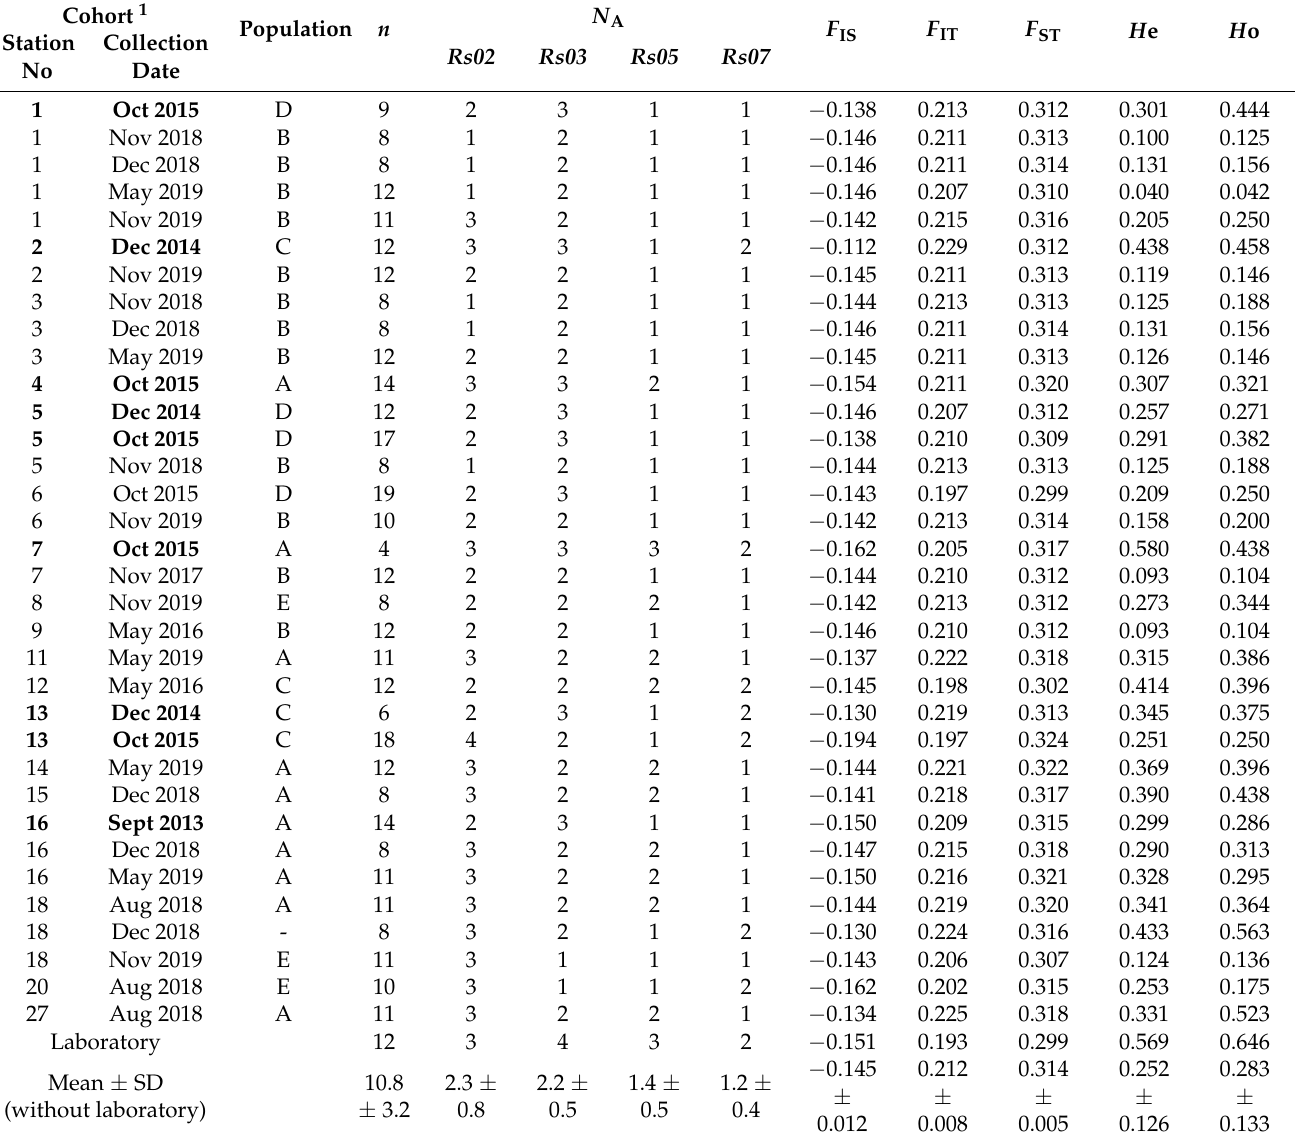
Table 3. Statistics of microsatellite loci and F -statistics for Reticulitermes speratus cohorts collected at Kindai University